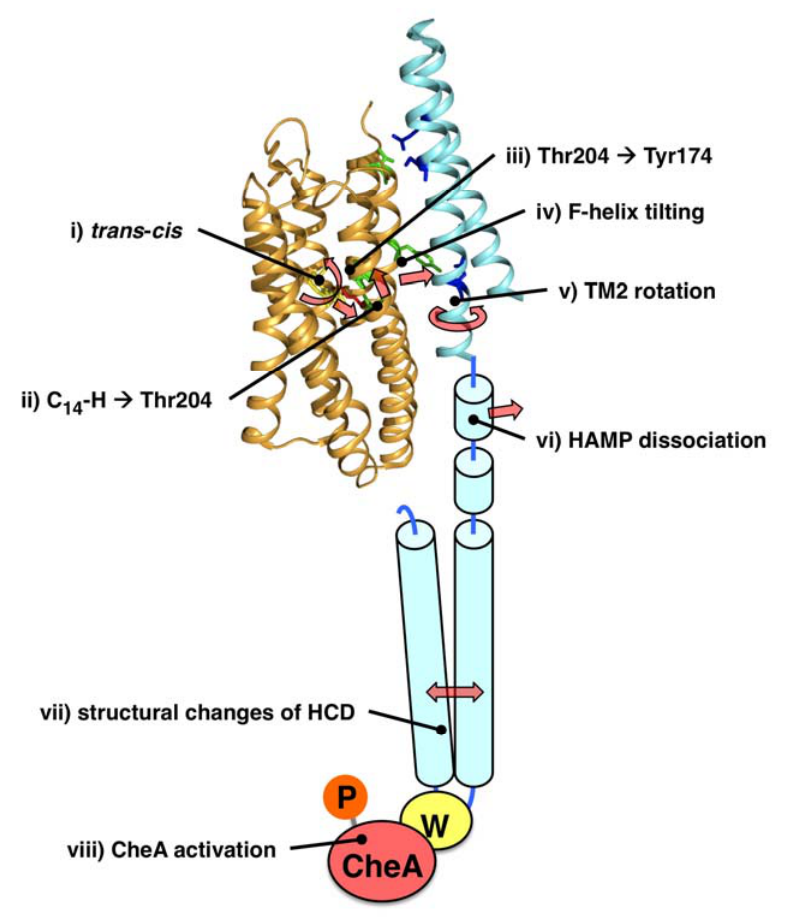
Figure 5. Model for signal transduction mechanism of SRII-HtrII